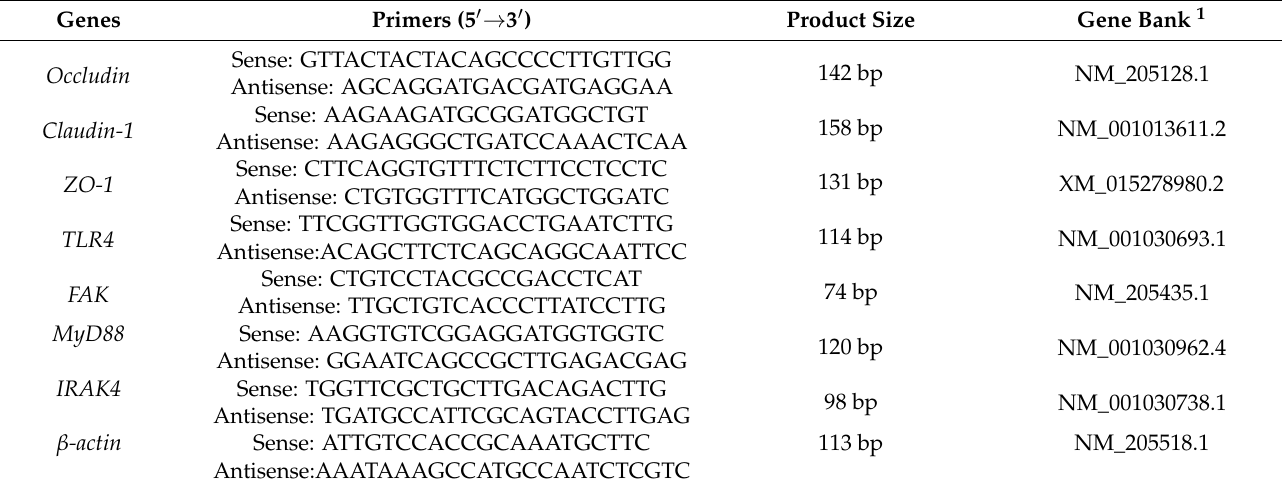
Table 2. Sequences used for real-time PCR